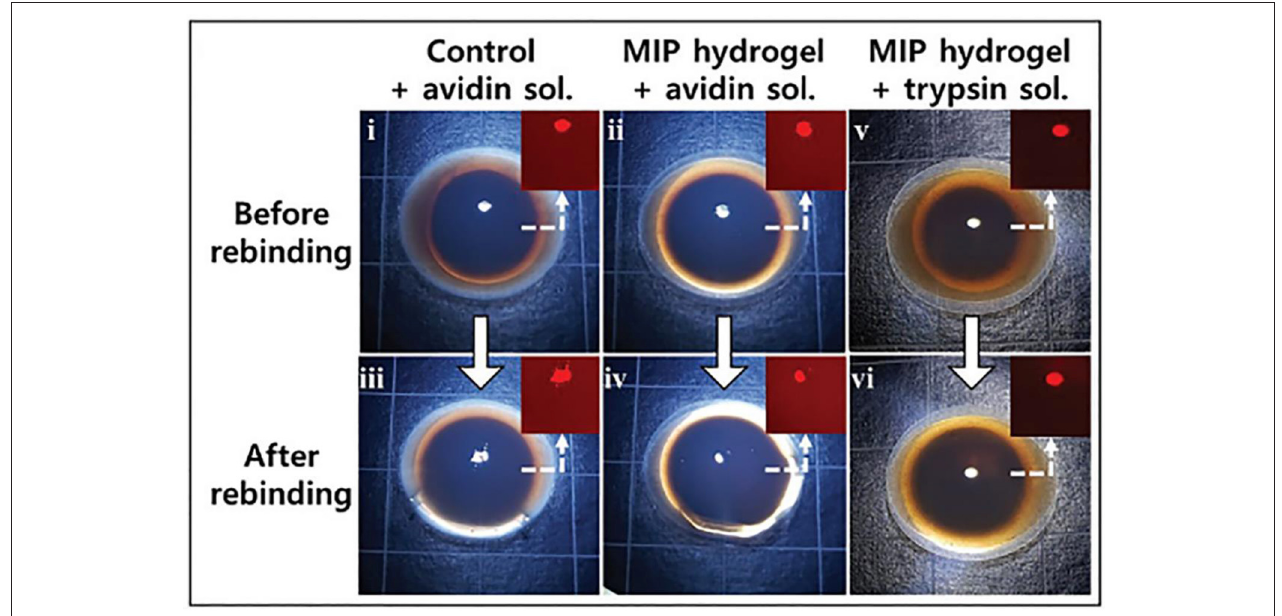
FIGURE 7 | Photographs of light reflected from the hydrogel with various silica nanoparticle concentrations. The insets show an expanded photo of the hydrogel center with only red light remaining (reprinted with the permission of Jinn et al., 2019; copyright 2019 Royal Society of Chemistry).